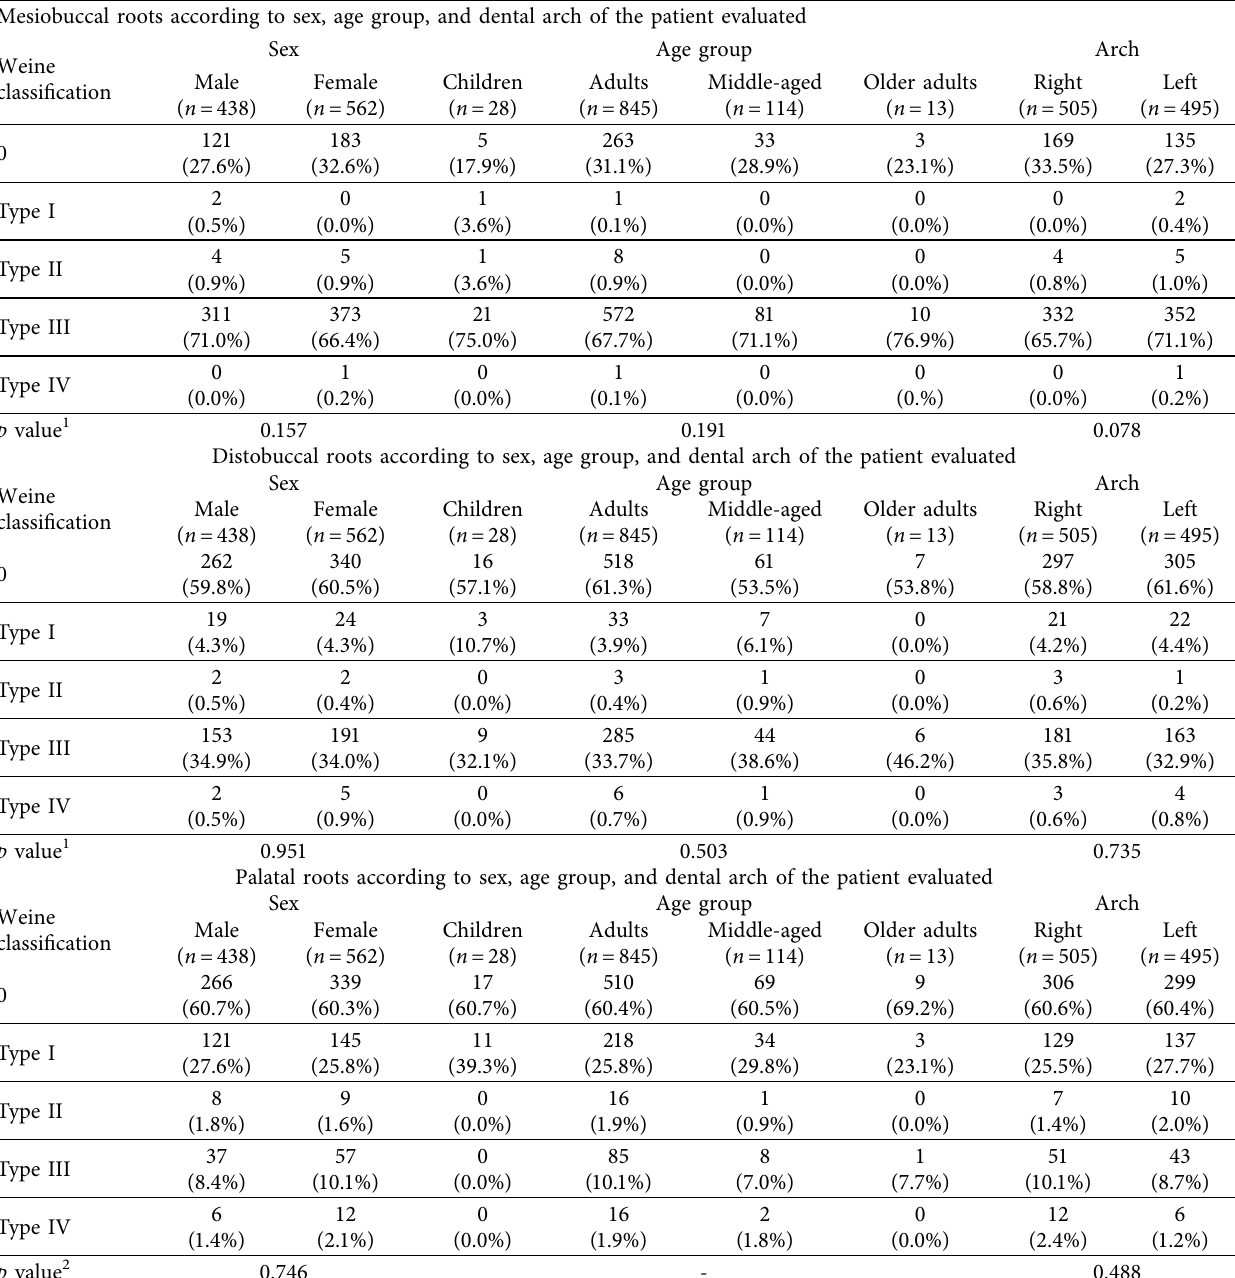
Table 4: Distribution of the different morphological types proposed by Weine et al . [14] for mesiobuccal roots, distobuccal roots, and palatal roots according to sex, age group, and dental arch of the patient